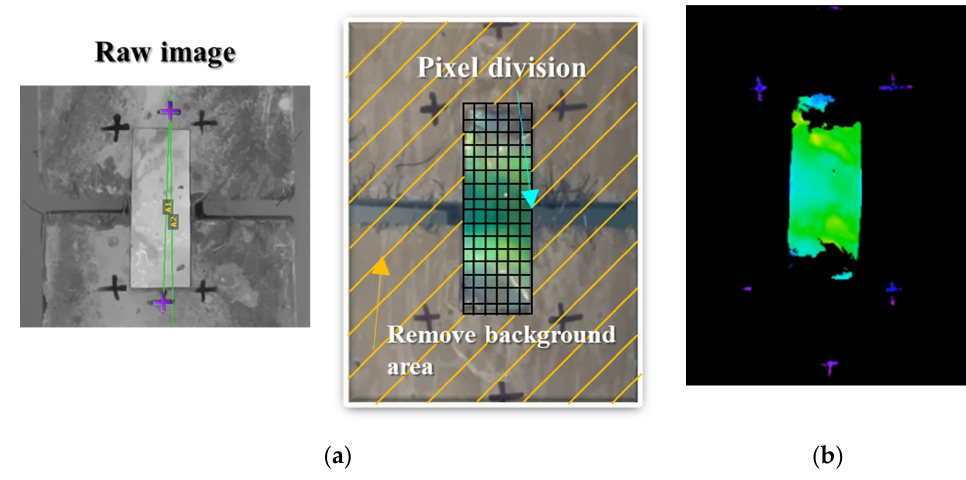
Figure 4. Results of pixel segmentation and background removal process for image analysis of the captured mechanochromic sensor. ( a ) Image control for improved image accuracy; ( b ) control result. Table 5. Image background removal process for color extraction of mechanochromic